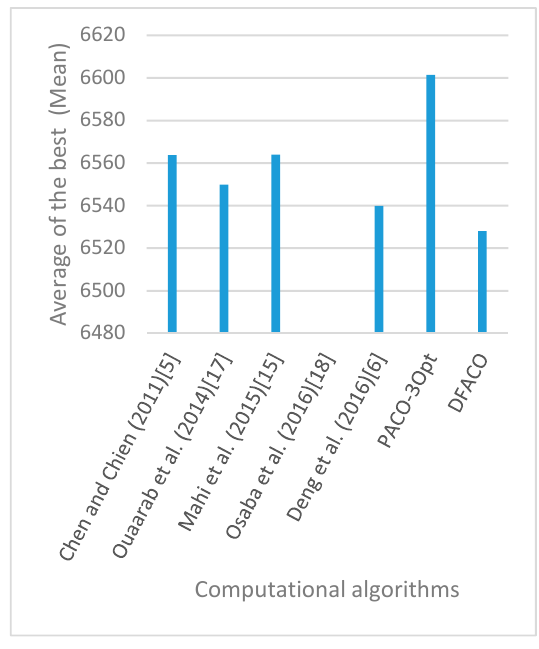
Figure 14. Average of best solutions obtained for instance ch150 by all algorithms.